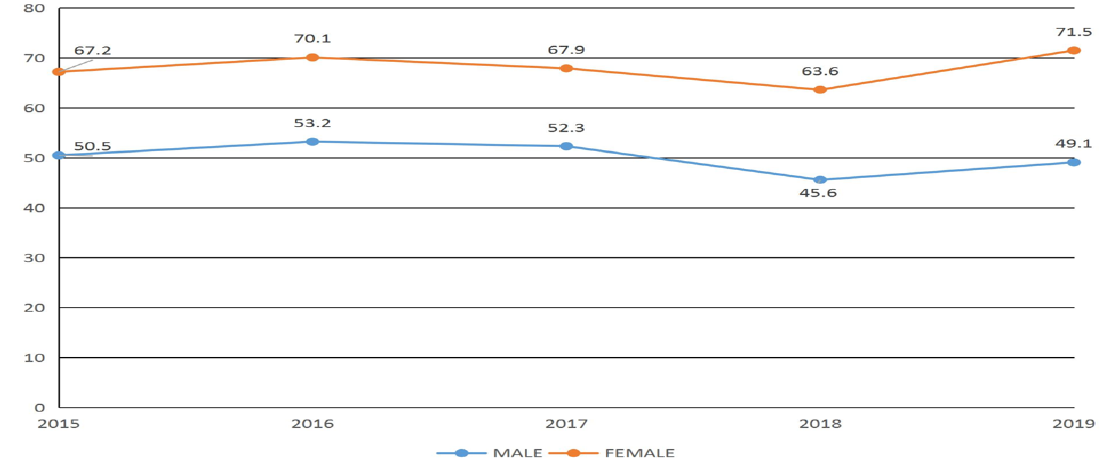
Figure 3. H. pylori seropositivity trend among gender of the study participants within the 5 year study duration.